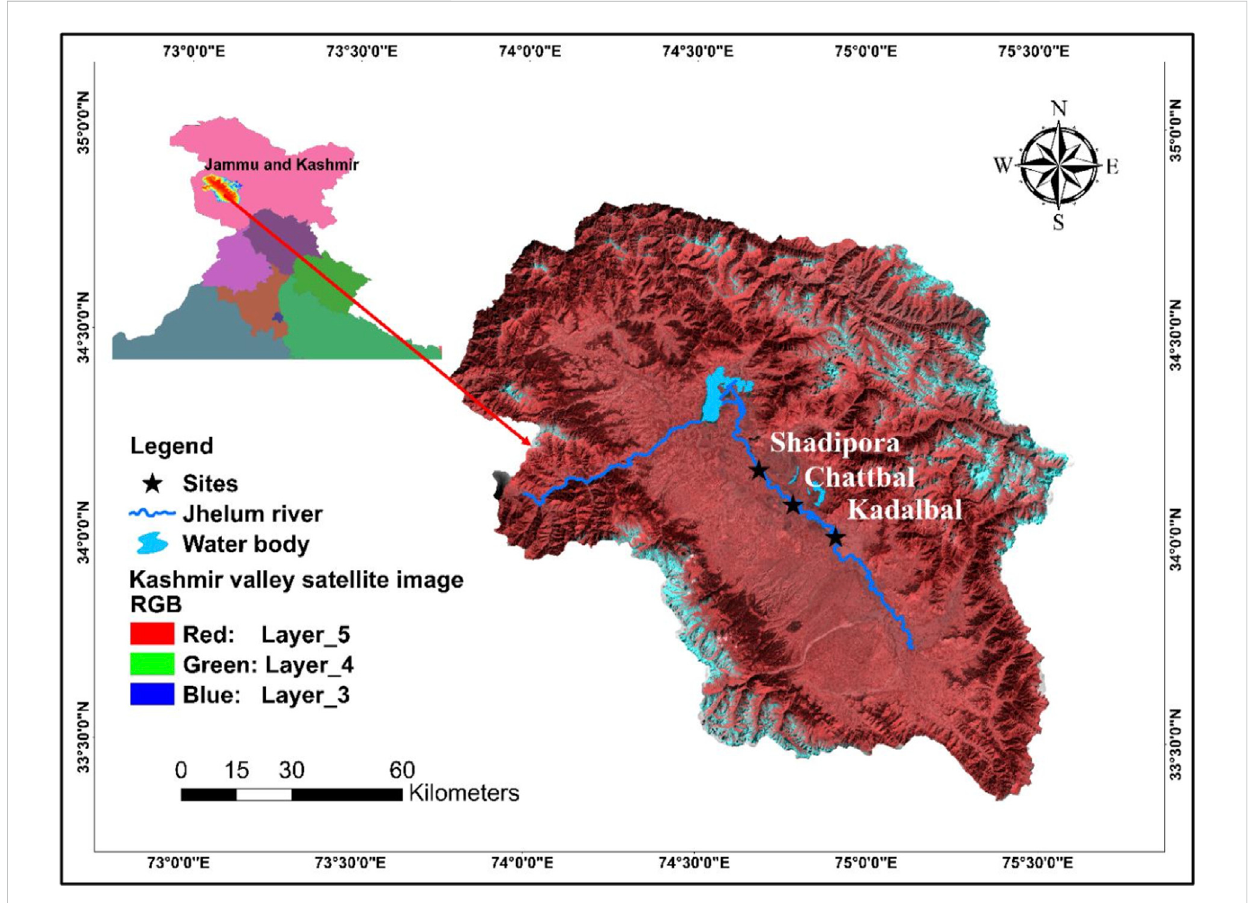
FIGURE 1 Map showing study sites of River